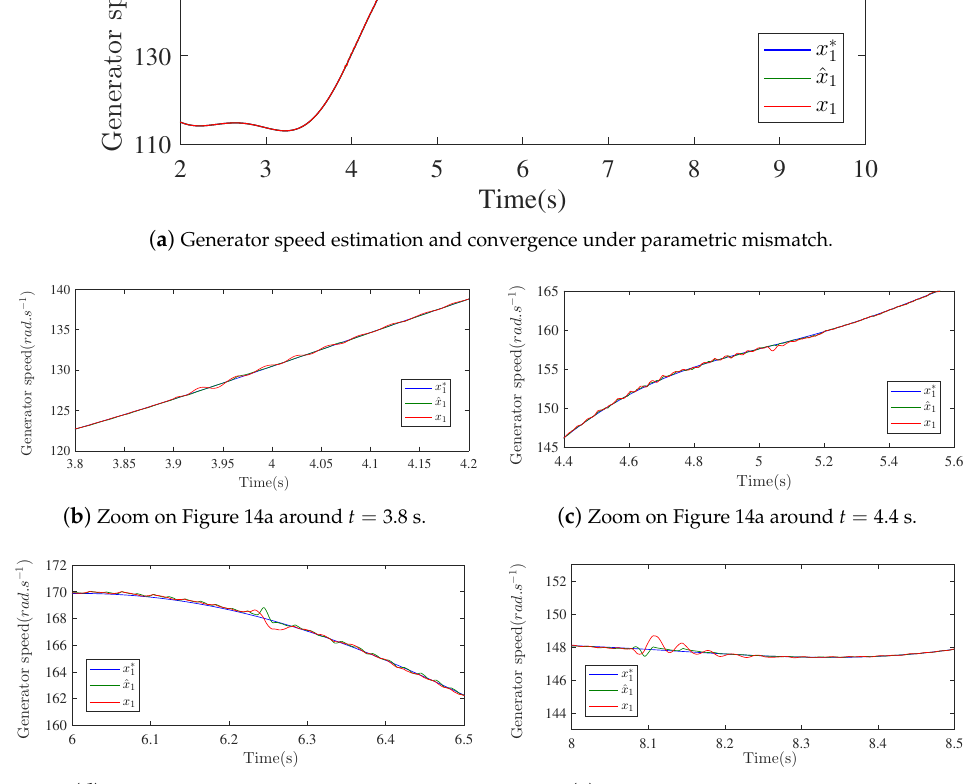
( d ) Zoom on Figure14a around t = 6 s. ( e ) Zoom on Figure14a around t = 8 s. Figure 15. Generator speed feedback control convergence under parametric